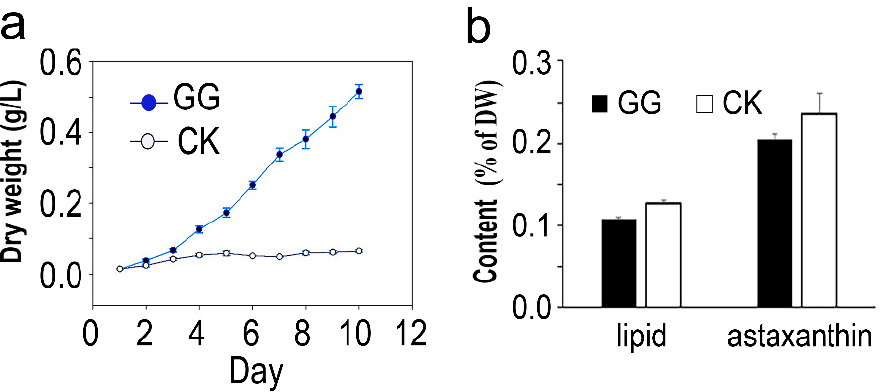
Figure 1. ( a ) Algal dry weight of Chromochloris zofingiensis grown under optimal conditions in the medium. ( b ) The lipid and astaxanthin content at Day 10 of C. zofingiensis with (GG) and without (CK) glucose addition. Each value represents the mean ( ± SD) of three biological